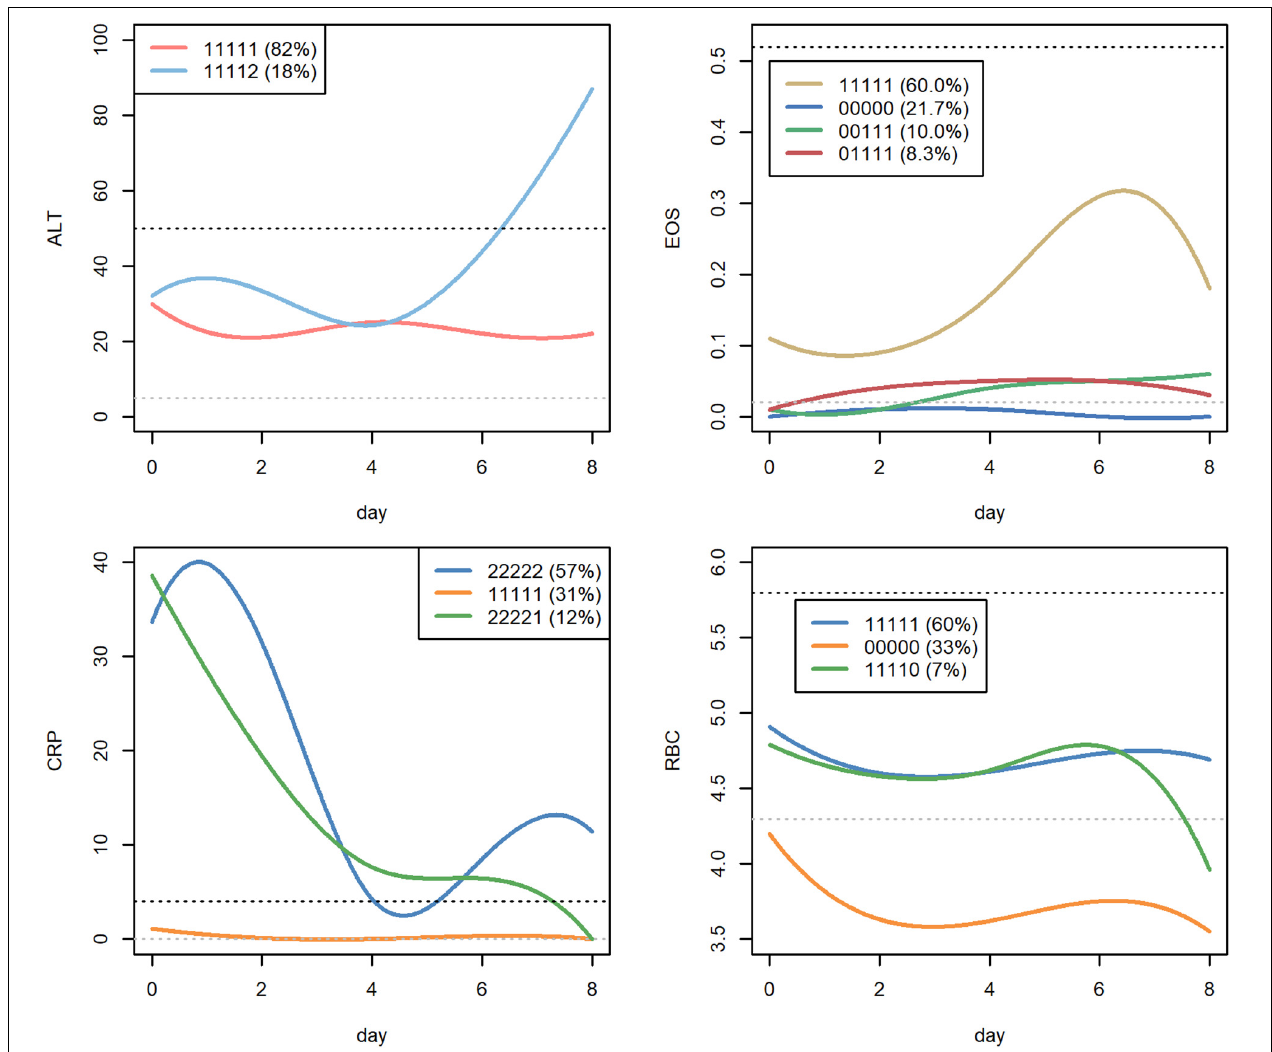
FIGURE 3 | Dynamic detection of biochemistry indices in COVID-19 patients. The first five hospital records of biochemistry indices, including ALT, CRP, EOS, and RBC, were shown for dynamic analysis. The numbers 0, 1, and 2 in the dynamic change pattern mean that the biochemical indices of COVID-19 patients are lower than the standard value, within the healthy range, and higher than the expected value,